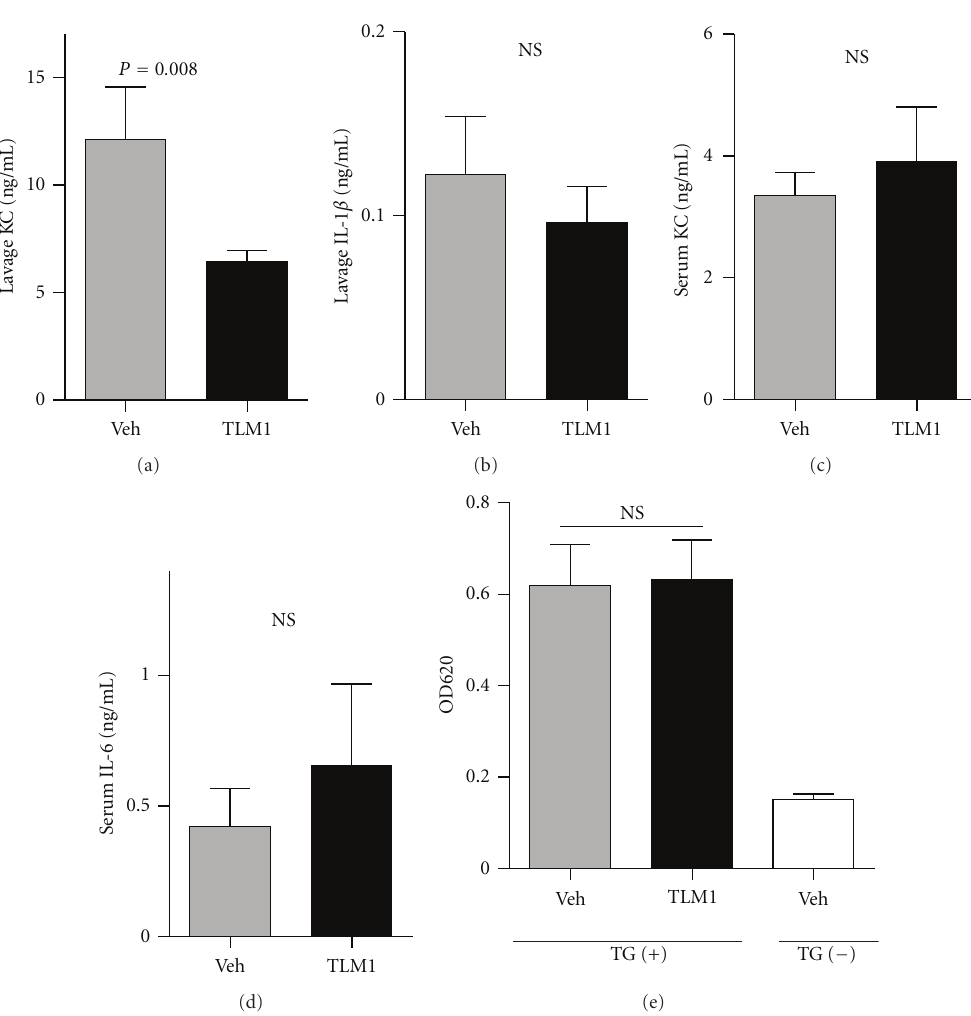
Figure 3: Tolerimod1 treatment reduced local chemokine release but had no e ff ect on systemic proinflammatory cytokine levels. TG-elicited peritonitis was induced in Tolerimod1 (TLM1) or vehicle (veh)-treated mice ( n = 8–10 per group). Sera and peritoneal lavage were harvested 3h after TG injection. Levels of KC (a) and IL-1 β (b) in the lavage and KC (c) and IL-6 (d) in sera were measured by ELISA. IL-1 β , TNF α , and IL-10 in the sera or lavage, or IL-6 in the lavage, were below detection levels. (e) Vascular permeability was measured by Evans blue assay. Peritoneal lavage was collected 2h after TG injection. Data shown are mean ± SEM and are pooled from 2 independent experiments that showed similar trends. P values are compared between vehicle (veh)- and Tolerimod1 (TLM1)-treated group by Mann-Whitney test. NS indicates not